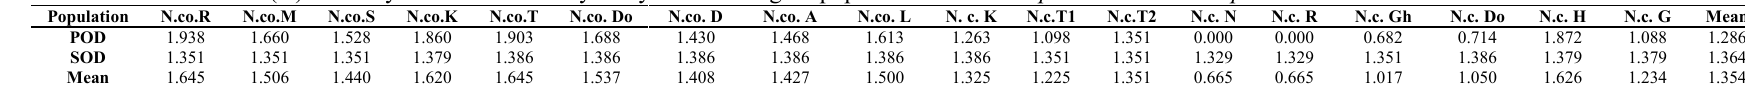
Table 3 The Shannon (H) diversity index for two enzyme systems among 18 populations of N. complanata and N. crispa . Population